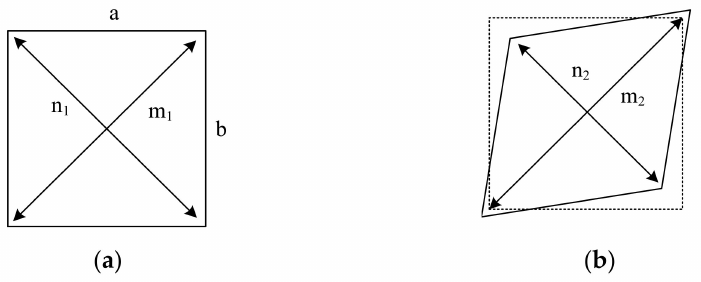
Figure 13. Shear deformation of the joint